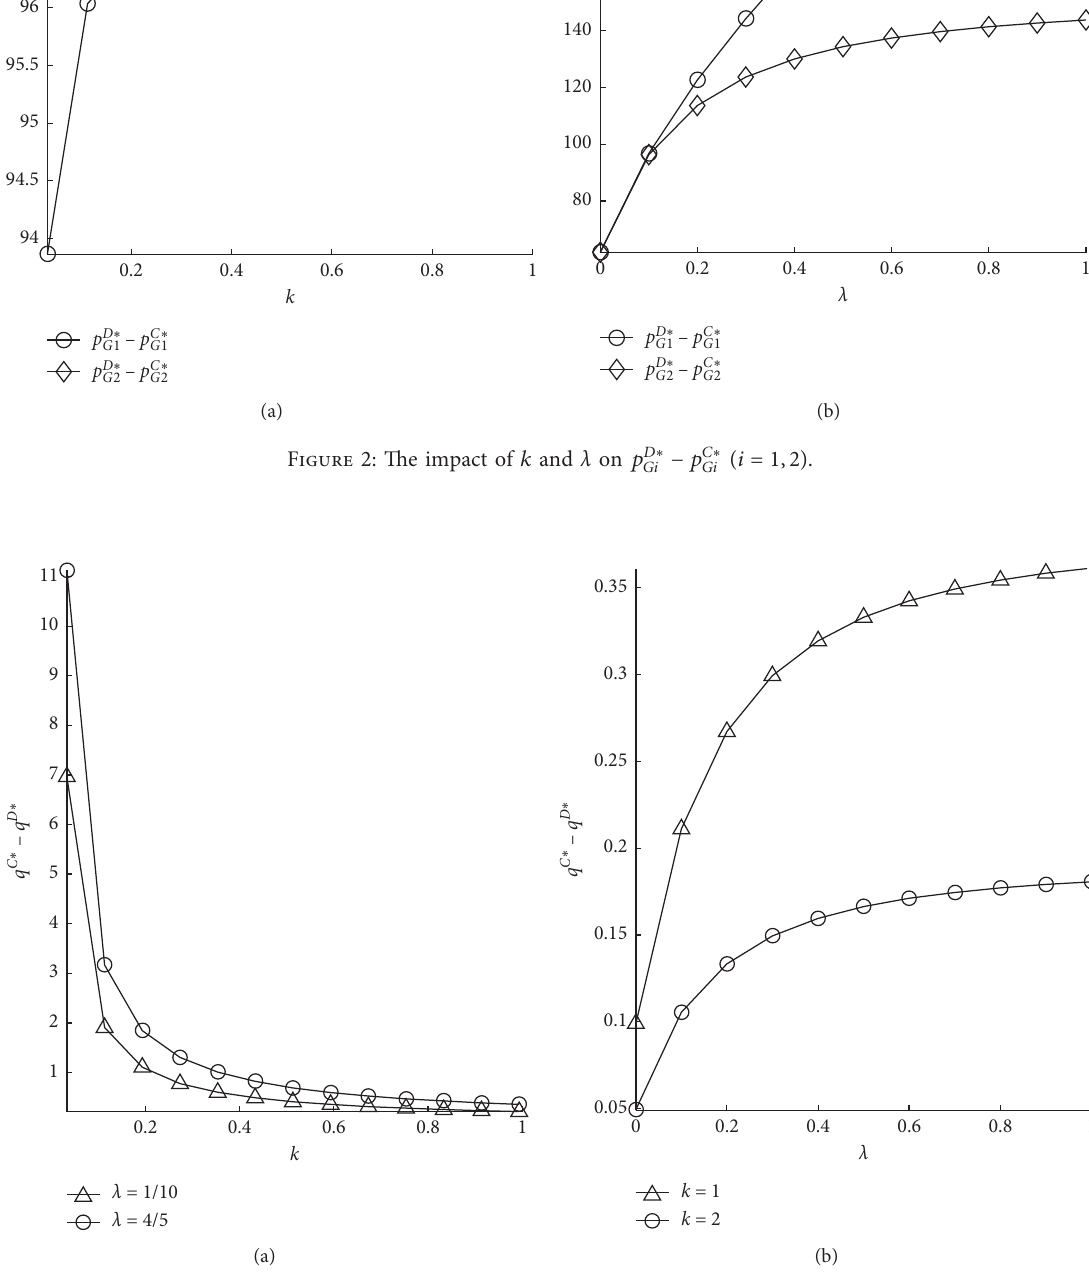
Figure 3: The impact of k and λ on q C ∗ − q D ∗ .